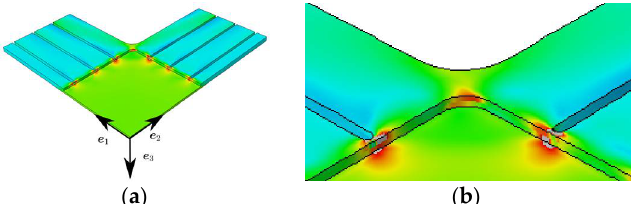
Figure 5. ( a ) FE results for equi-biaxial load at a displacement of the specimen arms of 0.2 mm, normal strain (cid:2013) (cid:2869)(cid:2869) ( b ) Detail from ( a ).